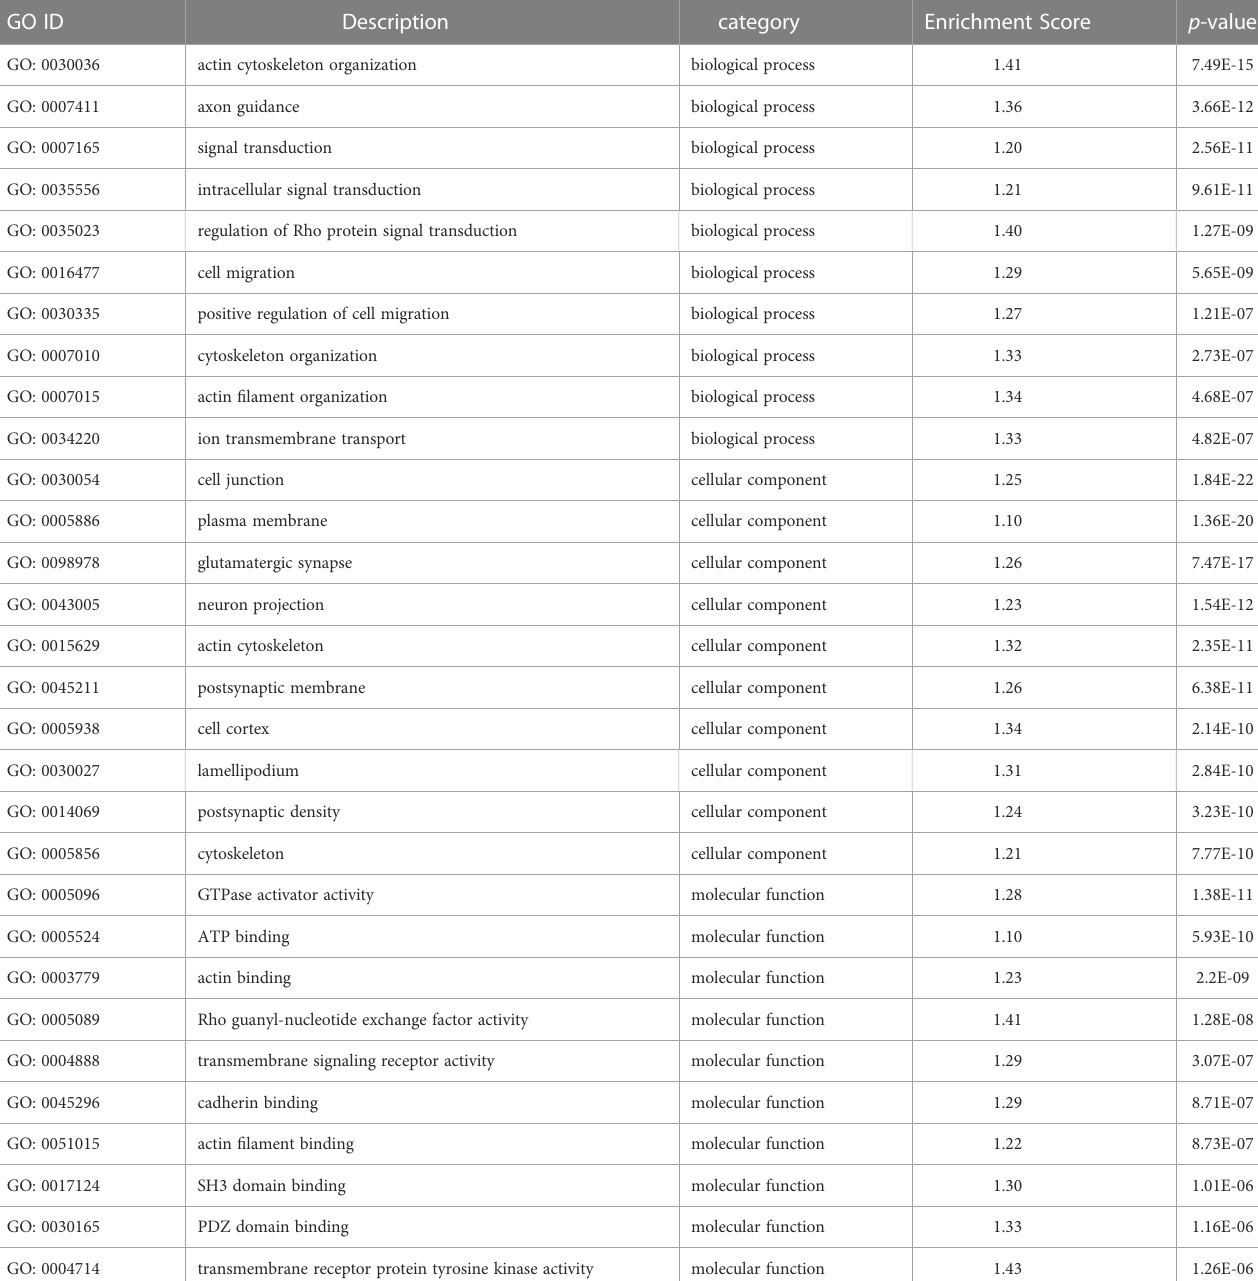
TABLE 4 GO analysis of DMRs target DMGs in gills of large yellow croaker under low-salinity stress. GO